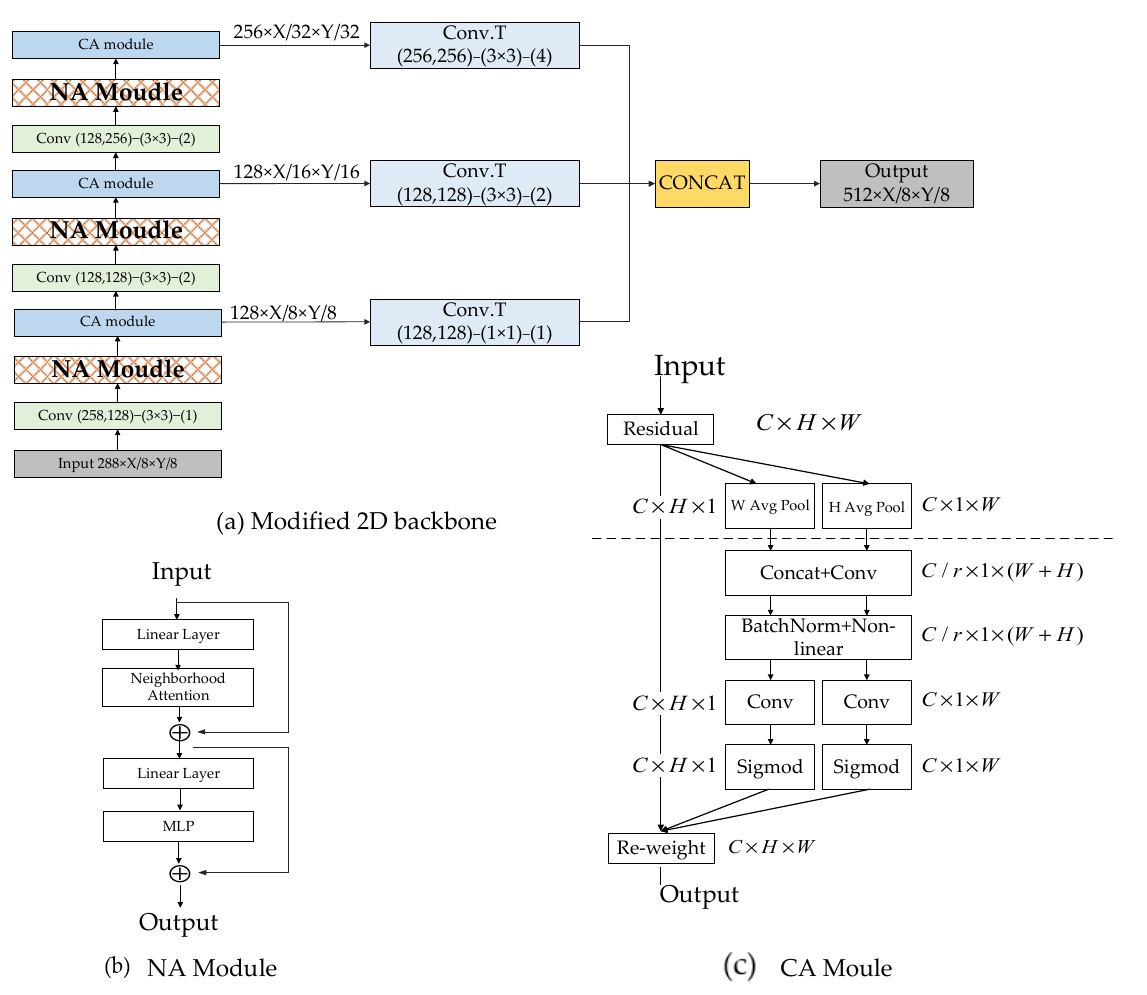
Figure 6. Modified 2D backbone. ( a ) The 2D backbone, where “Conv” denotes the convolutional layer and “Conv.T” represents the transposed convolutional layer. Format of the layer setting follows “channels kernel size -(strides)”. Detailed structure of ( b ) NA module and ( c ) CA module.